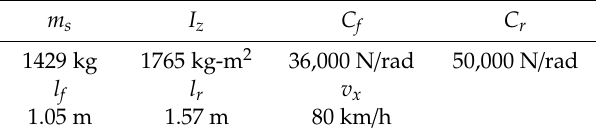
Table 1. Parameters and values of D-Class SUV in